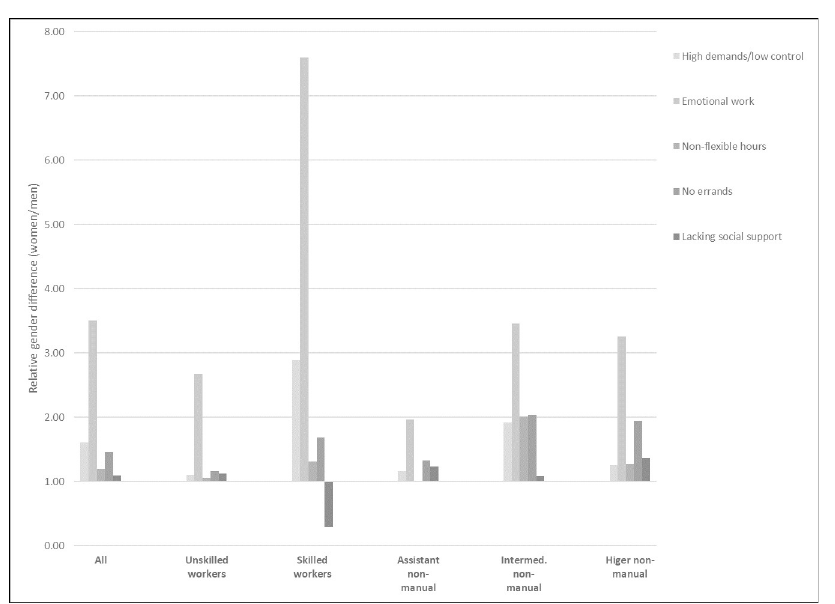
Fig 2. Gender differences in psychosocially demanding work, by class. Relative differences (percentage share women/percentage share men). Differences > 1 indicate that the condition is more common among women than among men, differences < 1 indicate that the condition is more common among men than among